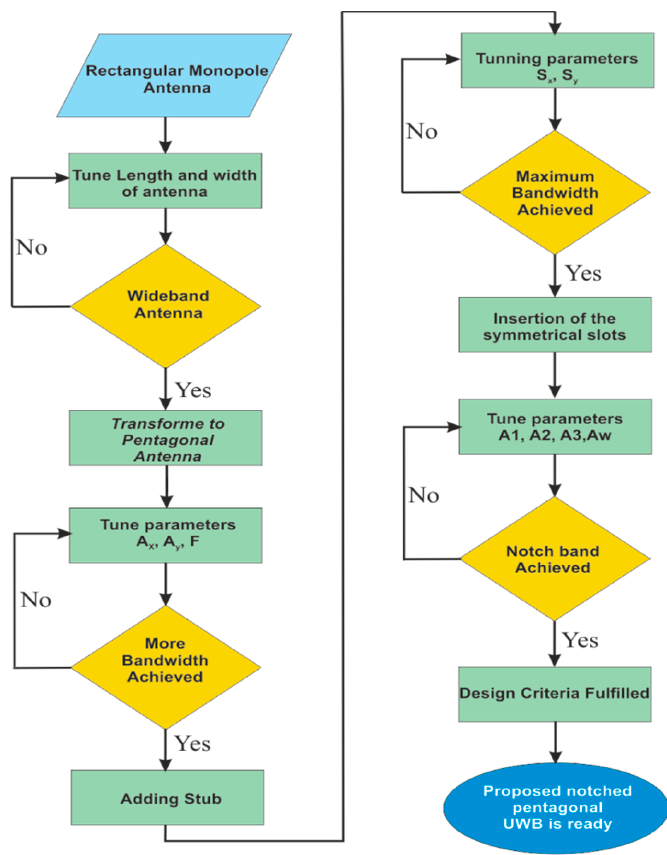
Figure 7. Design and optimization procedure of the proposed antenna.